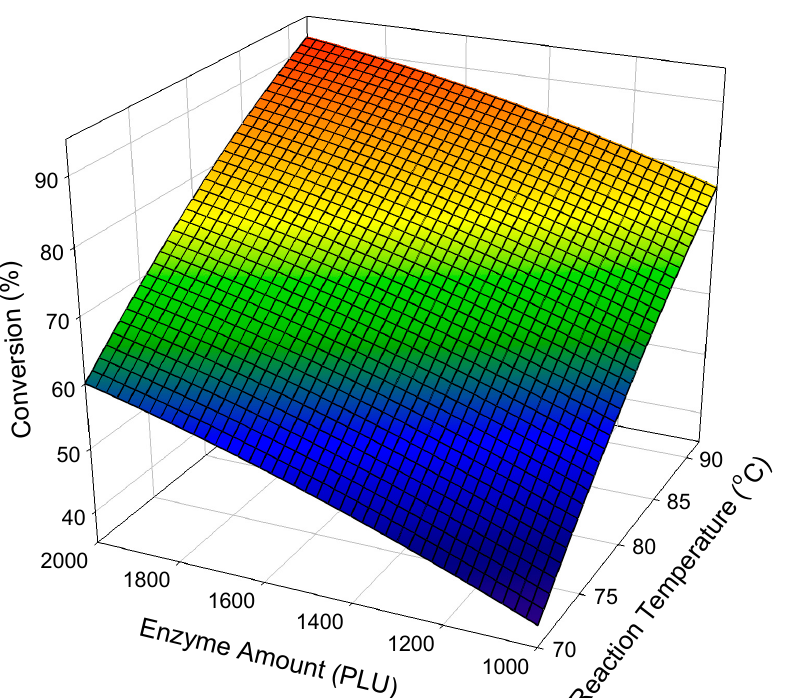
Figure 3. Response surface plots show the correlation between the molar conversion of octyl ferulate synthesis and reaction parameters (enzyme amount and reaction temperature). Catalysts 2018 , 8 , x FOR PEER REVIEW 6 of 10